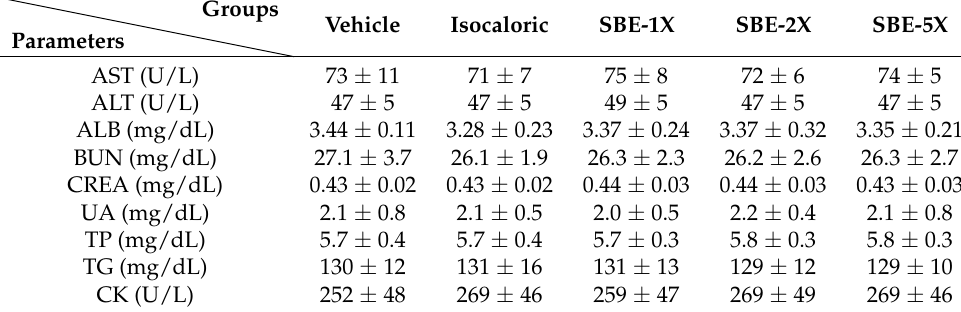
Table 2. Effects of SBE supplementation on biochemical